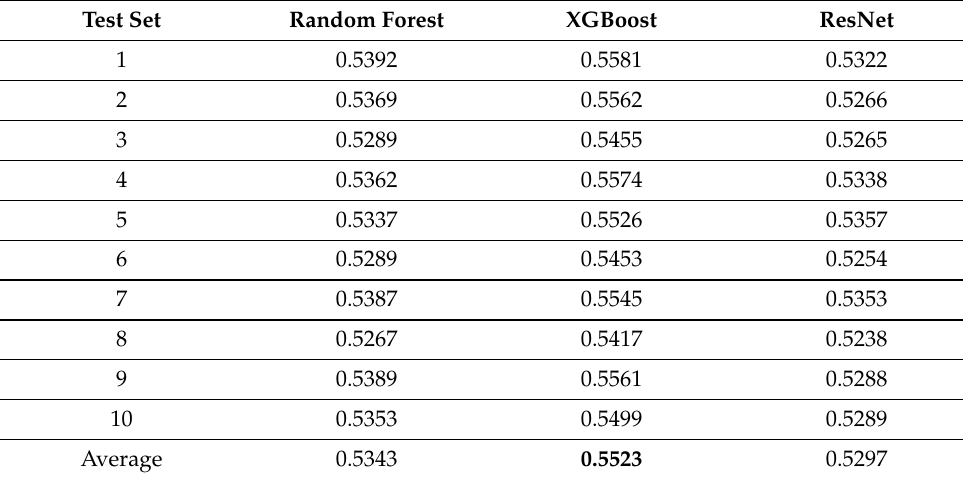
Table 5. Experiments with different regression algorithms.